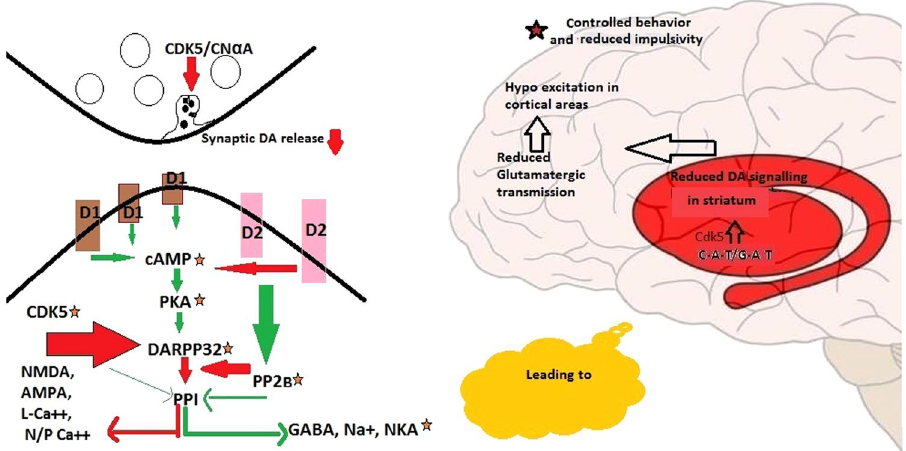
Figure 2. Proposed role of CDK5 haplotypes CAT and GAT in ADHD through modulation of dopaminergic transmission. lines indicate activation and lines indicate deactivation or suppression. Pre-synaptic exocytosis is guided by optimum balance between Cdk5 and CN α A 30 . Straital DA release in the striatum